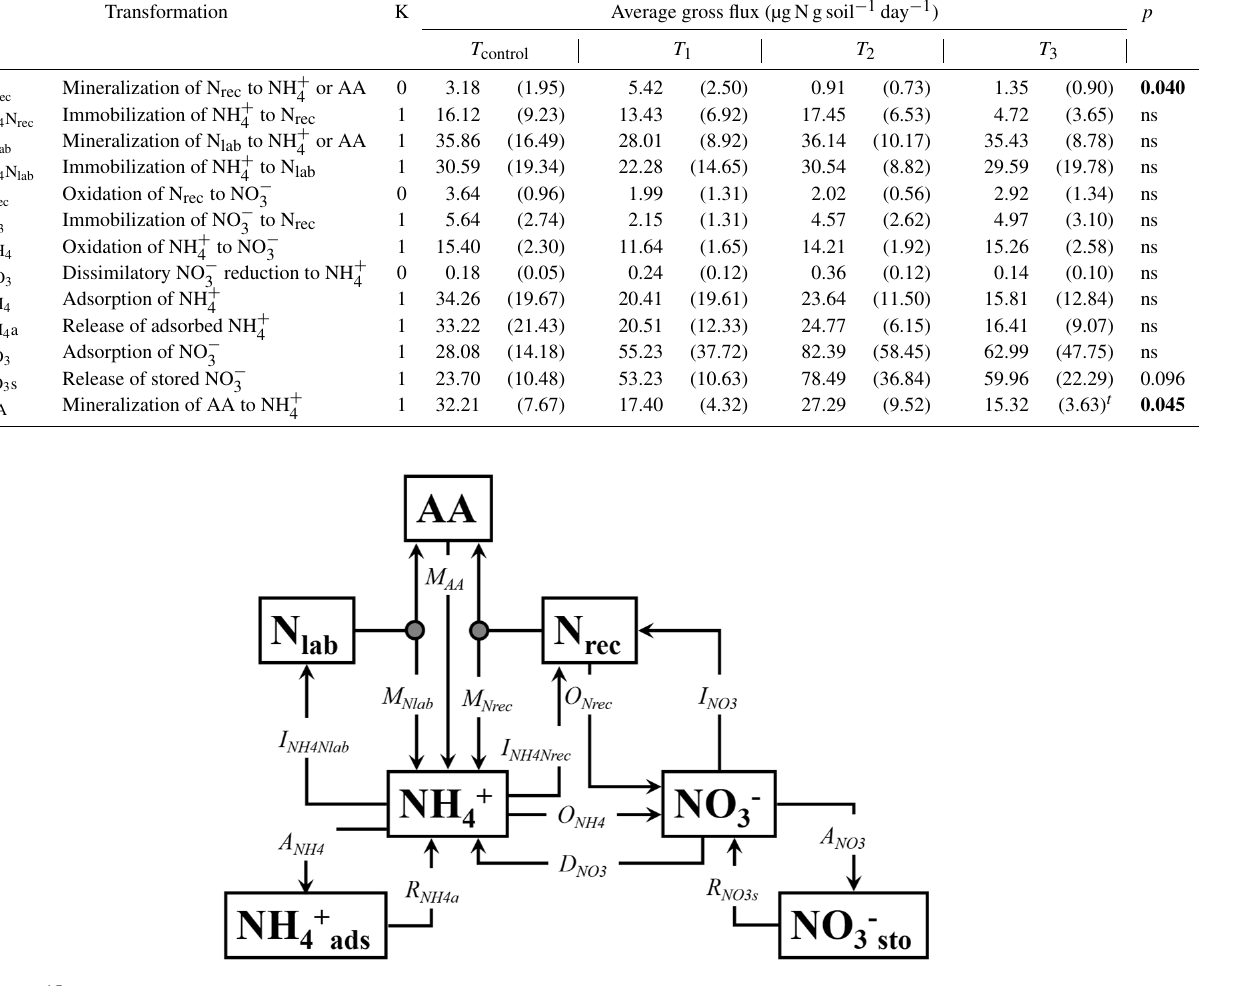
Figure 2. 15 N tracing model for analyses of gross soil N transformation rates. Abbreviations of the transformations are explained in Table 1. The pools are explained in Sect.